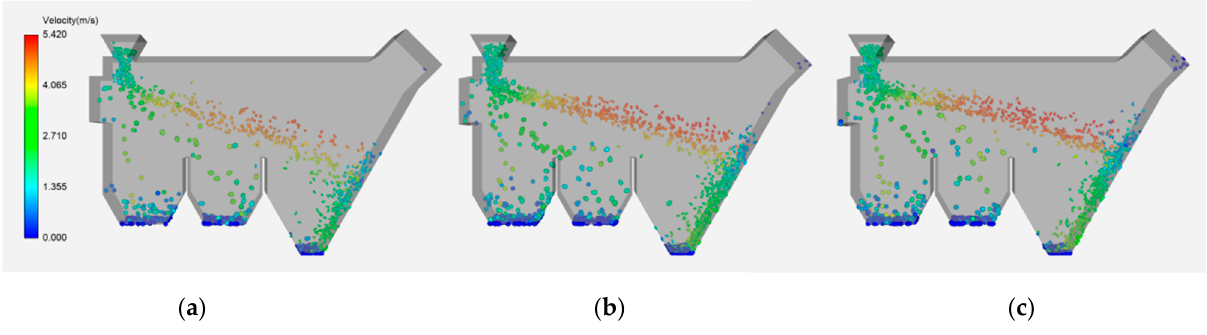
Figure 12. Airflow velocity contour plots of different types of airflow inclined angles: ( a ) 0°; ( b ) 7.5°; ( c ) 15°.